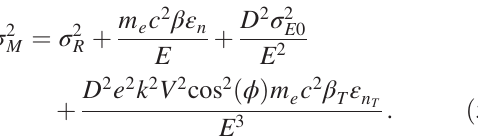
FIG. 1. Sketch of the measurement